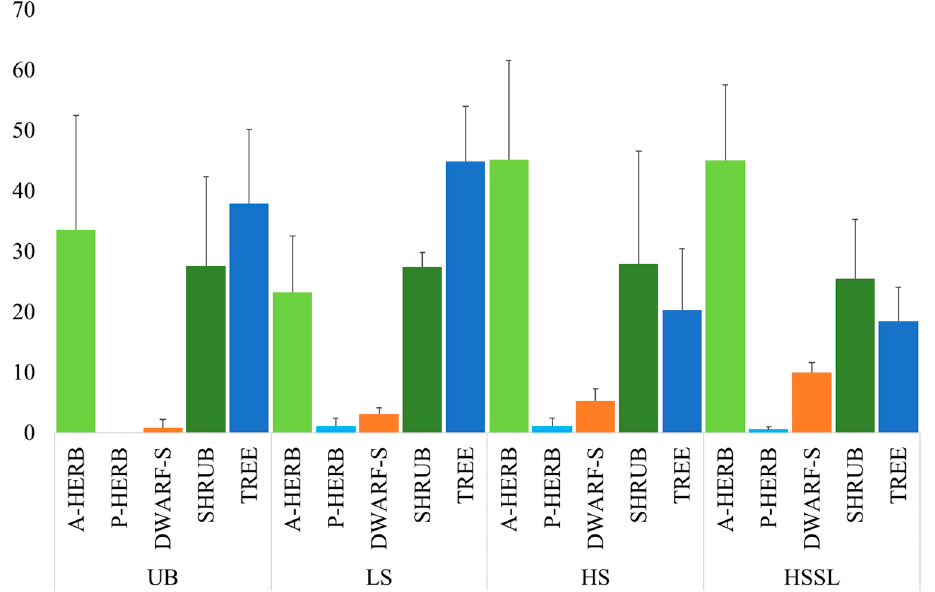
Figure 2. Mean relative values (including standard error) of the life form composition (LIFE ‐ FORM, %) in the studied areas (UB: unburned; LS: low ‐ burn severity; HS: high ‐ burn severity; HSSL: salvage logging in high ‐ burn severity) according to the defined categories: trees (TREE), shrubs (SHRUB), dwarf shrubs (DWARF ‐ S), perennial herbs (P ‐ HERB), and annual herbs (A ‐ HERB).